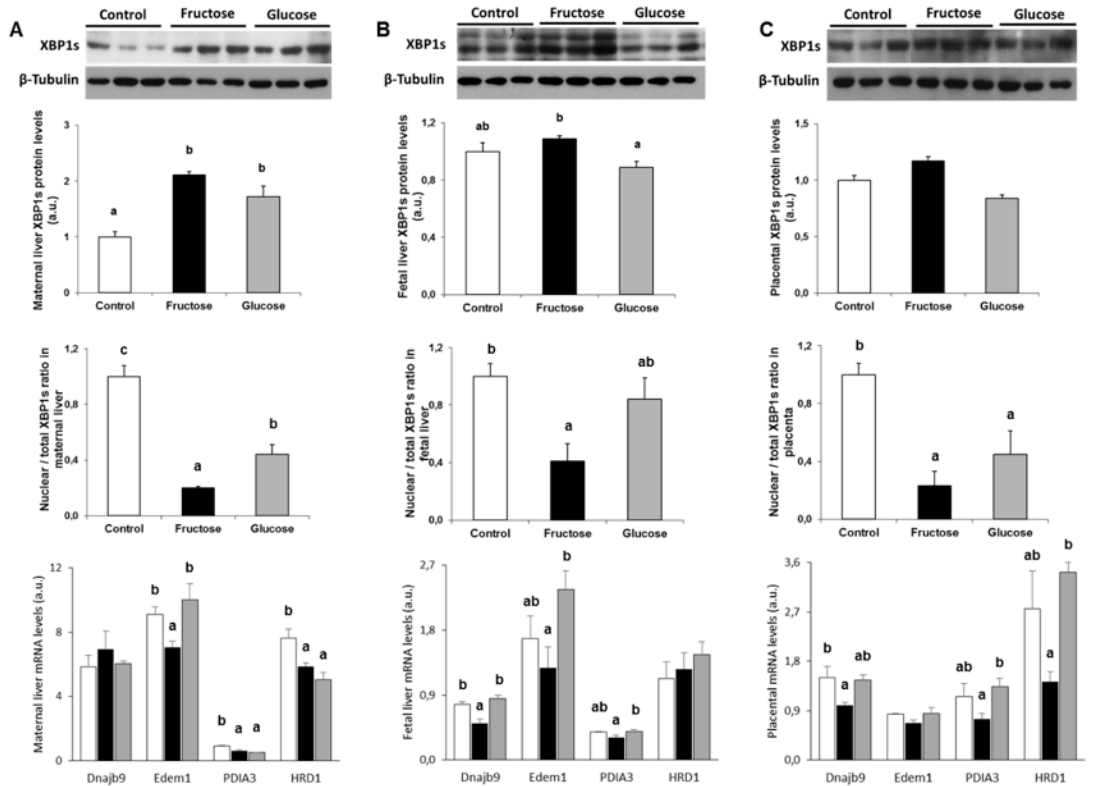
Figure 4. Maternal intake of a 10% w/v fructose solution throughout gestation diminishes nuclear translocation of XBP1s. Western blots and bar plots showing total XBP1s protein (upper panel); bar plots showing the ratio between nuclear XBP1s and the total XBP1s protein (middle panel); and mRNA for XBP1s target genes (lower panel) levels from ( A ) maternal liver, ( B ) fetal liver, and ( C ) placenta of control (empty bar), fructose- (black bar), and glucose-fed (grey bar) pregnant rats. Values were normalized to β -actin or β -tubulin levels and expressed in arbitrary units (a.u.). Bars represent the mean ± S.E. of values obtained from five maternal livers, fetal liver pools, or placenta pools of the same litter for protein gene expression and 6–7 samples for mRNA expression. Values not sharing a common letter are significantly different at P < 0.05. XBP1s: spliced X-box-binding protein; Dnajb9: DNA J heat shock protein family member B9; Edem1: endoplasmic reticulum degradation enhancing alpha-mannosidase like protein 1; PDIA3: protein disulphide isomerase 3; HRD1: HMG-CoA reductase degradation protein 1.